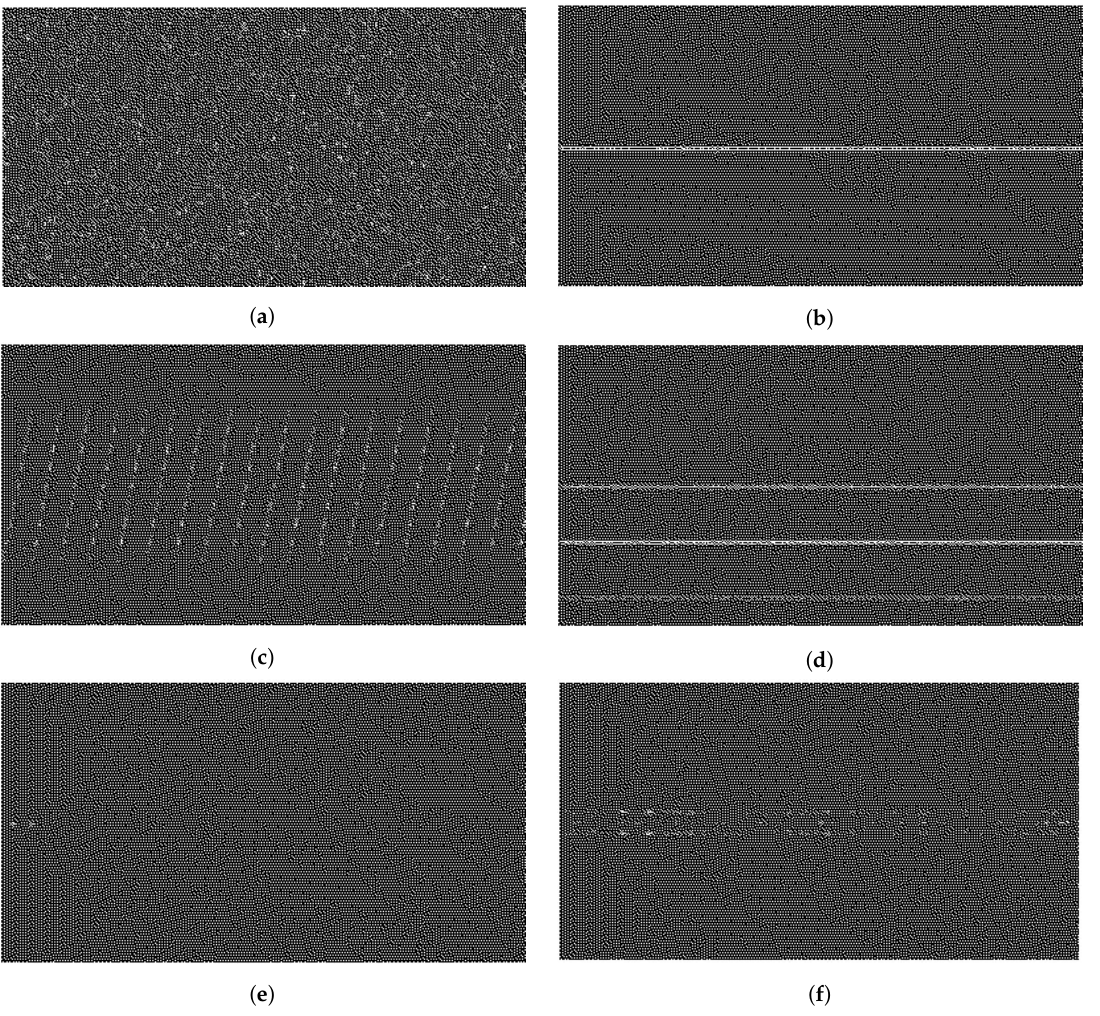
Figure 6. Binary spectrogram images of common jamming signals in the baseband. ( a ) No jammer. ( b ) AM jammer. ( c ) Chirp jammer. ( d ) FM jammer. ( e ) Pulse jammer. ( f ) NB